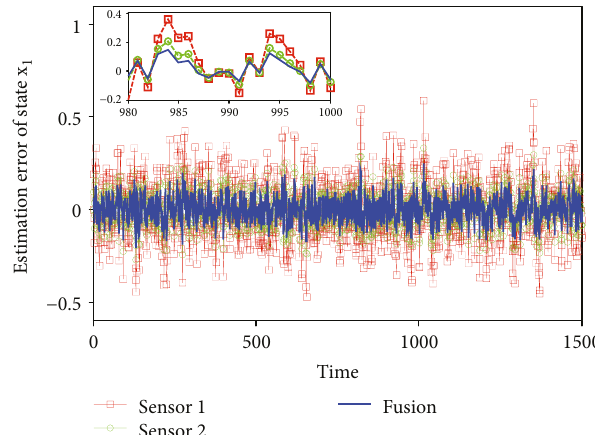
Figure 4: Input signal, output signal, and multisensor measurements ( L =200).